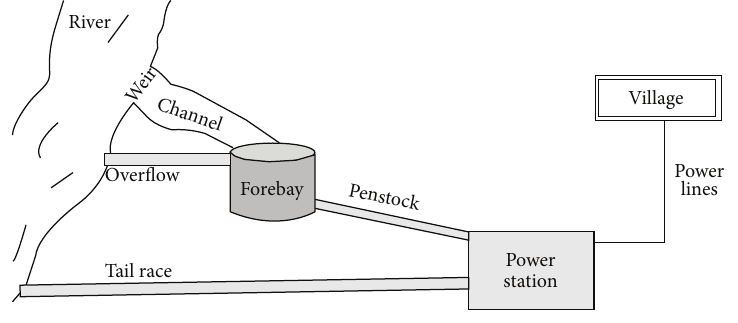
Figure 2: A typical microhydrosystem structure.